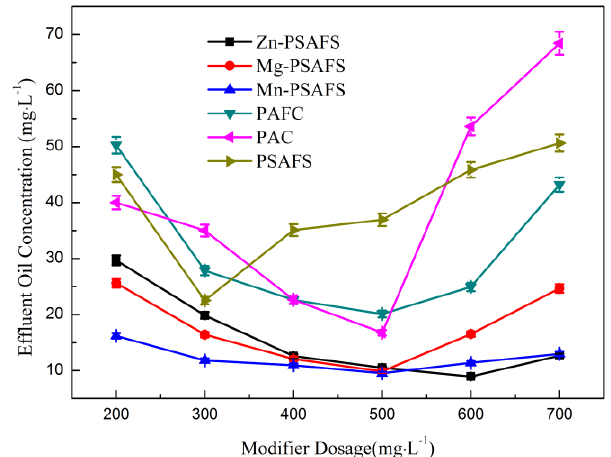
Figure 8 . Oil-removal performance comparison. Figure 8. Oil-removal performance